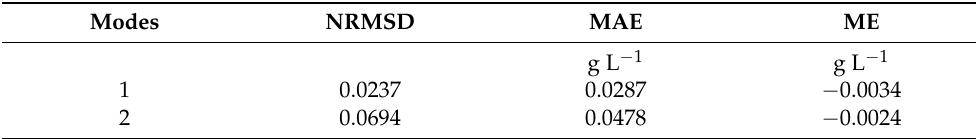
Figure 6. Laboratory experiment and 1D numerical simulation results using dissolution rates given by Equation (10) plotted against the L/S ratio. For both experiments 1 ( a ) and 2 ( b ), the fit is given with an uncertainty range ± σ (dashed line) given by Equation (10). Table 5. Discrepancy in uranium concentration at the outlet of the tube with experimental data for modes 1 and 2 (see Figure 6).